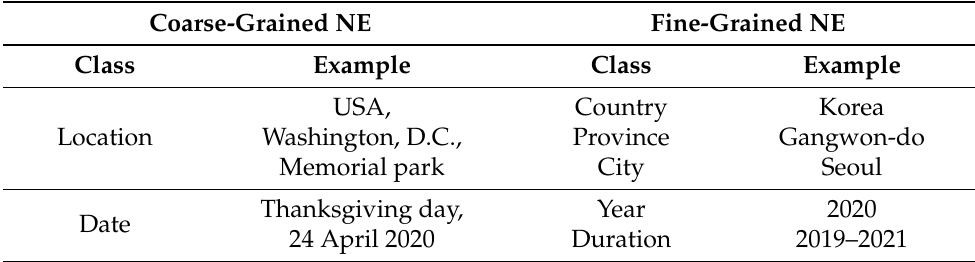
Table 1. Example of two-level NE